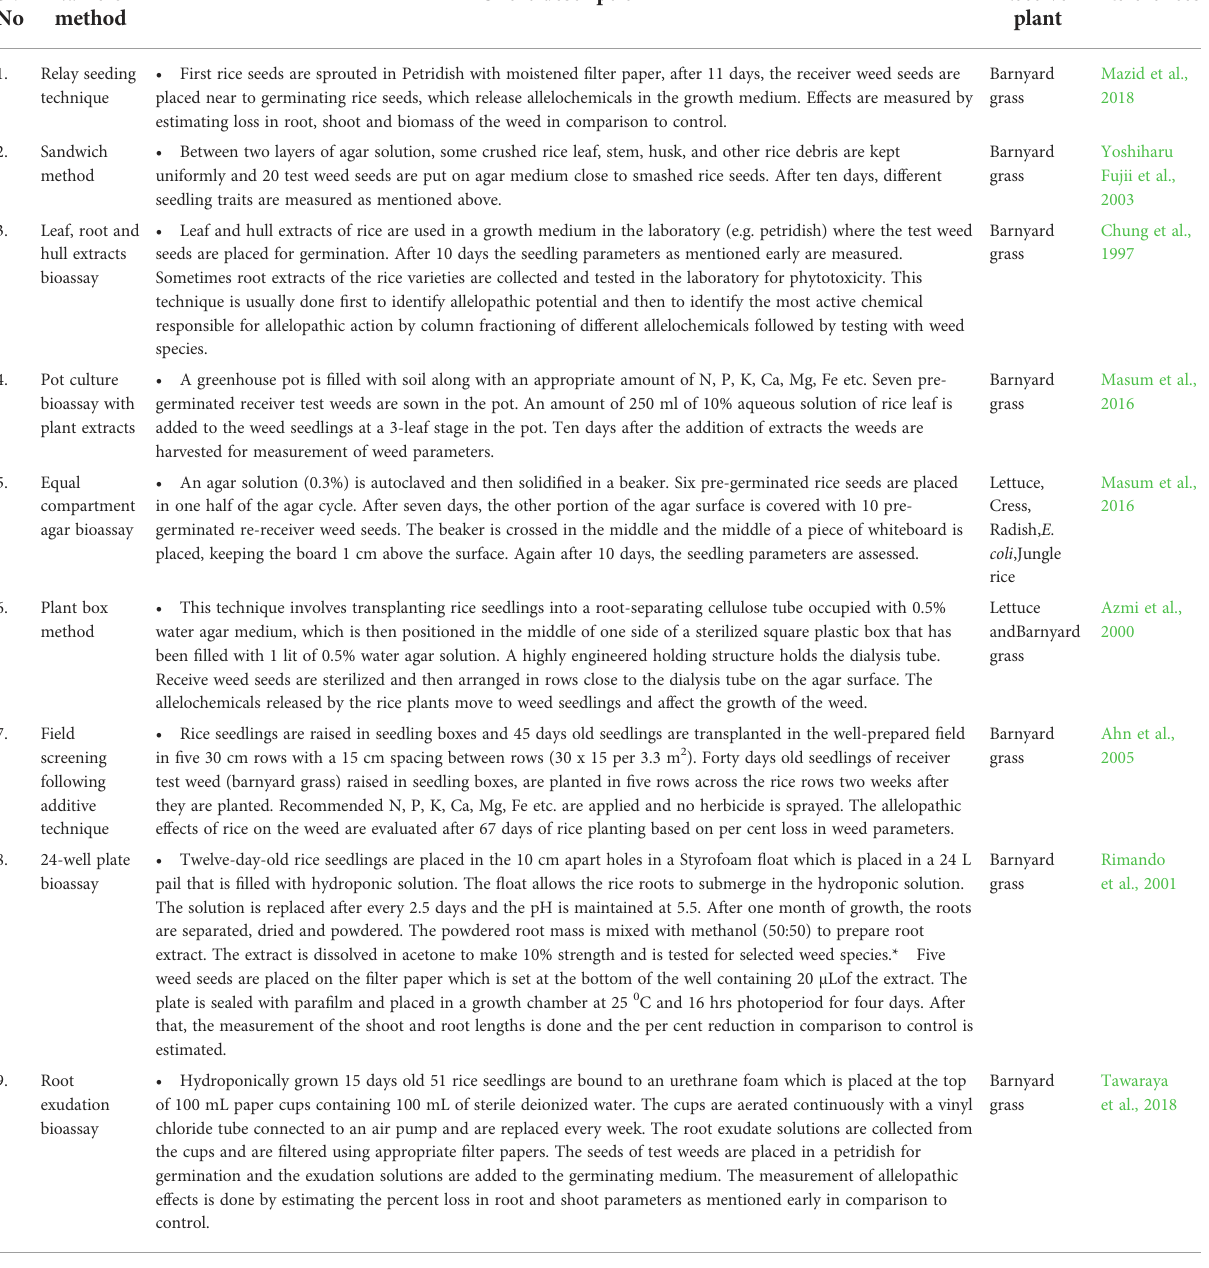
TABLE 2 The screening methods usually used to detect allelopathic potential in rice. Sl.